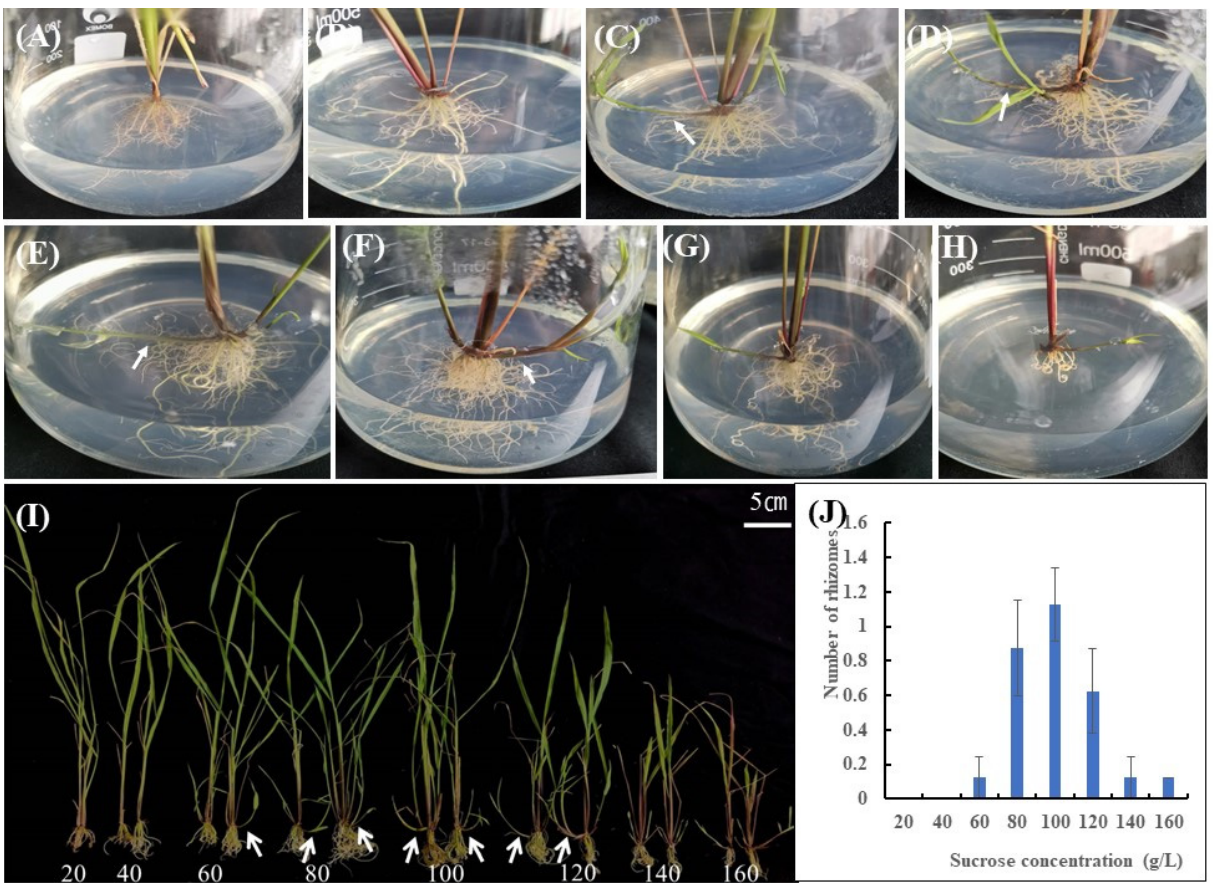
Figure 1. Effects of different sucrose concentrations on rhizomes of Oryza longistaminata . The corresponding sucrose concentrations in ( A – H ) are 20 g/L ( A ), 40 g/L ( B ), 60 g/L ( C ), 80 g/L ( D ), 100 g/L ( E ), 120 g/L ( F ), 140 g/L ( G ) and 160 g/L ( H ), respectively. Rhizomes are indicated with white arrows. ( I ) Phenotypes of the whole plants cultivated with various concentrations of sucrose. In ( J ), the abscissa represents different sucrose concentrations, and the ordinate represents the average number of rhizomes per plant under the corresponding sucrose concentration. The error bars represent standard deviation.